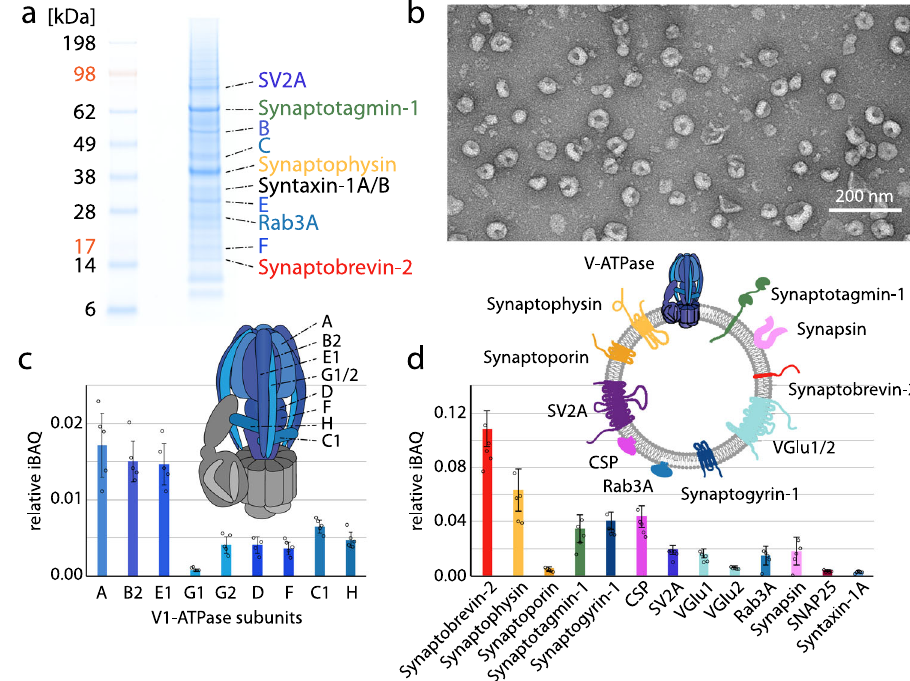
Fig. 1 Proteomic characterisation of synaptic vesicles. a SDS-PAGE of a typical preparation of synaptic vesicles ( n > 5). Selected major protein components are indicated. b Electron microscopy image of puri fi ed synaptic vesicles con fi rming integrity of the vesicles ( n = 3). c Relative iBAQ (intensity- based absolute quanti fi cation) of the V 1 -ATPase. Individual data points, the mean and the standard deviation from fi ve biological replicates are given. d Relative iBAQ of selected synaptic vesicle proteins. Individual data points, the mean and the standard deviation from fi ve biological replicates are given. The topology of major vesicle proteins is